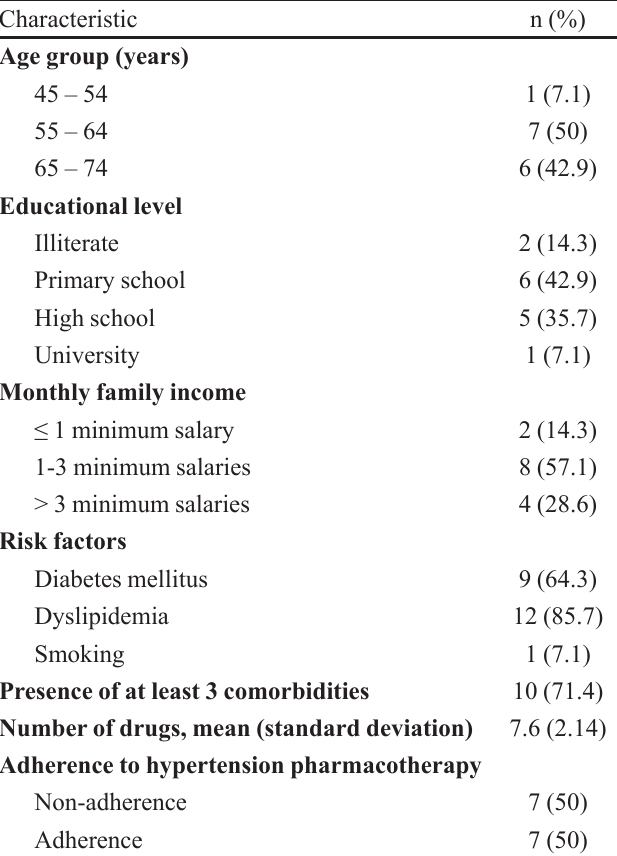
TABLE I - Sociodemographic and baseline clinical characteristics of hypertensive patients receiving Pharmaceutical Care within the Family Health